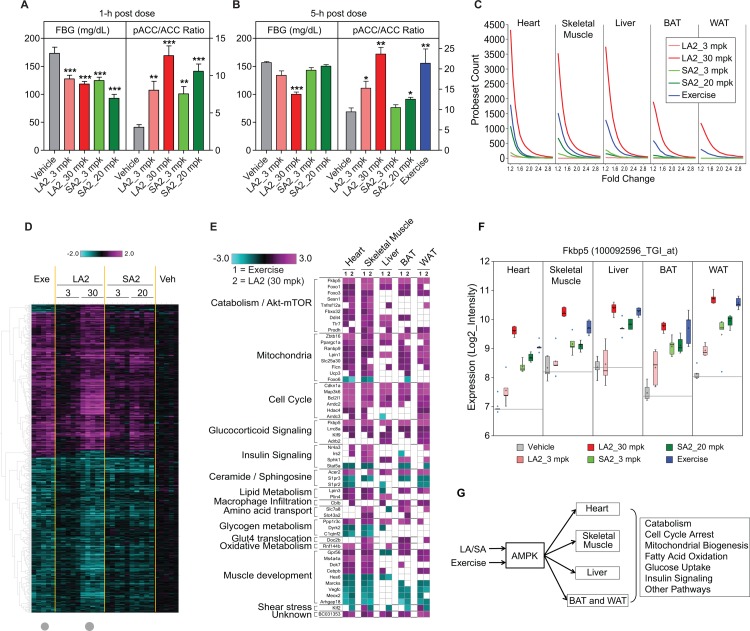
Comparison of pharmacological AMPK activation and exercise in lean C57BL/6 mice (n = 8).Effects of pharmacological AMPK activation on fasting blood glucose (FBG) and pACC/ACC ratio 1h (A) and 5h (B) post dose (LA2, 3 and 30 mg/kg, PO and SA2, 3 and 20 mg/kg, PO) in 12-week old lean C57BL/6 mice. The effects of 130 min treadmill exercise on pACC/ACC ratio (treadmill exercise at speed of 10 m/min) are also shown in (B); Data are represented as mean ± SEM. *p < 0.05, **p < 0. 01, ***p < 0.001 relative to vehicle. (C) Acute exercise and pharmacological AMPK activation have robust transcriptional effects in heart, skeletal muscle, and liver (n = 5). Tissues were collected 5 h post dose, or at the end of exercise. Shown are the number of probesets (y-axis) that met the fold change cutoffs (x-axis). Only the probesets with FDR_BH (False Discovery Rate Benjamini & Hochberg) p<0.1 were included. (D) For skeletal muscle gene expression profiling, 789 probesets are shown that met the +/- 1.2 fold change and FDR_BH p<0.1 threshold in both the exercise and LA2 (30 mg/kg, PO) groups (indicated by grey dots). The color gradient represents fold change compared to vehicle treated sedentary mice (-2.0 to 2.0 fold). (E) Pathway analysis of heart, skeletal muscle, liver, BAT, and WAT of C57BL/6 mice (1) exercised on treadmill for 130 min; and (2) treated with LA2 (30 mg/kg, PO). White boxes represent changes that did not reach statistical significance (1.2 fold and p<0.05). (F) Fkbp5 was one of six genes (represented by 7 probesets) that were significantly regulated by both acute exercise and acute pharmacological AMPK activation (LA2, 30 mg/kg, PO) in all 5 tissues profiled. Shown in the box plot are the log2_Intensity values per treatment group. (G) Schematic diagram summarizing the pathways regulated by exercise and direct AMPK activation.